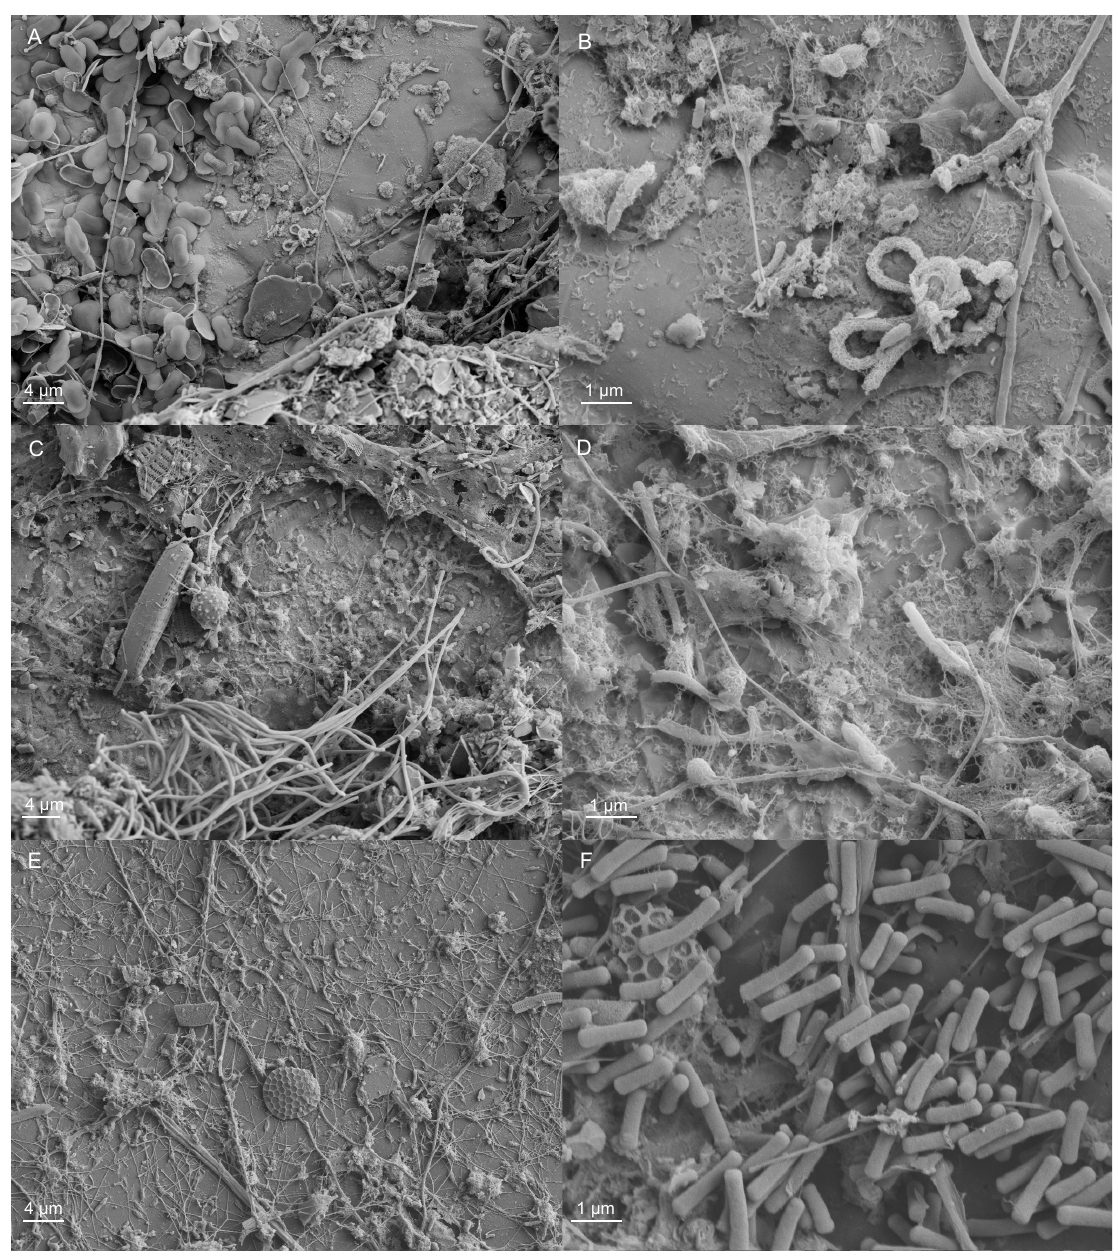
Figure 3. SEM images, showing the surfaces of coupons from the non-chlorinated system after three months of exposure. ( A , B ) 254SMO; ( C,D ) Ti alloy; ( E,F ) Inerta160.